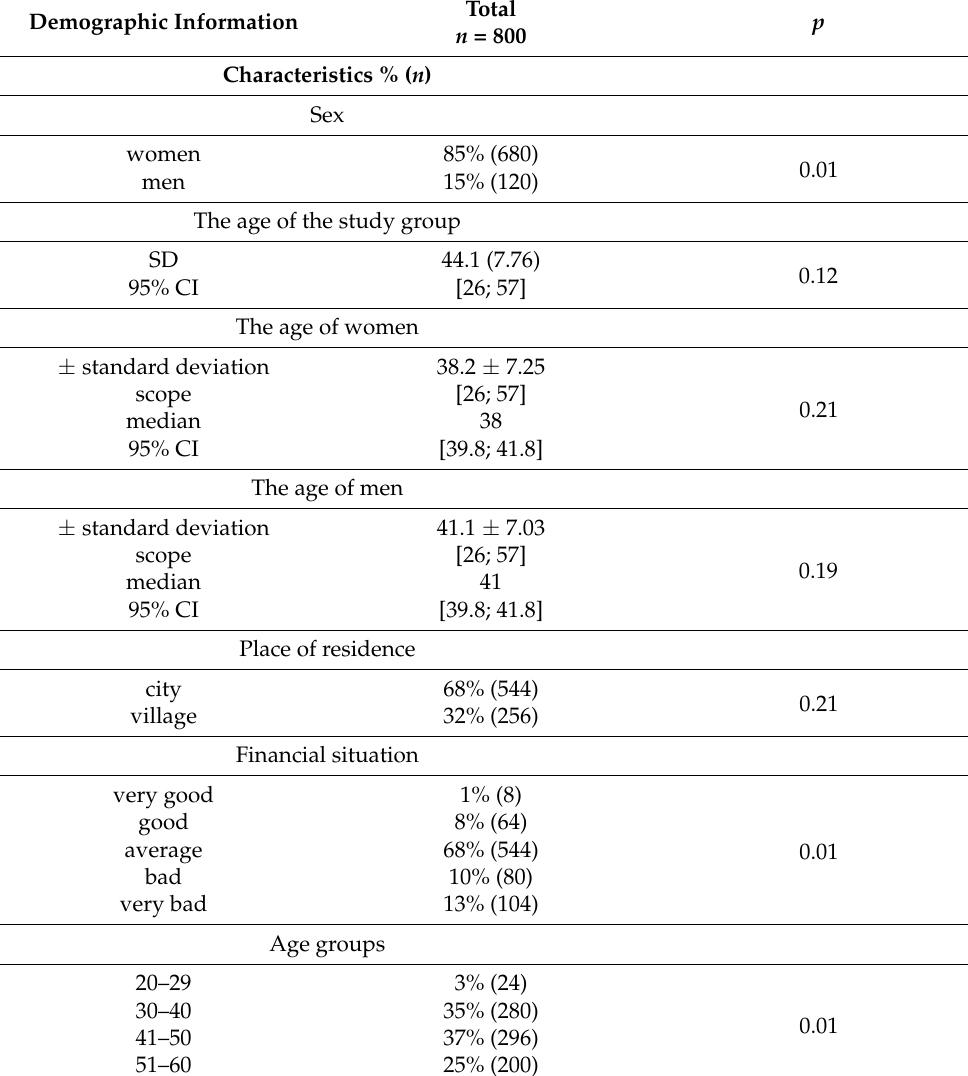
Table 1. Descriptive statistics of the examined group of